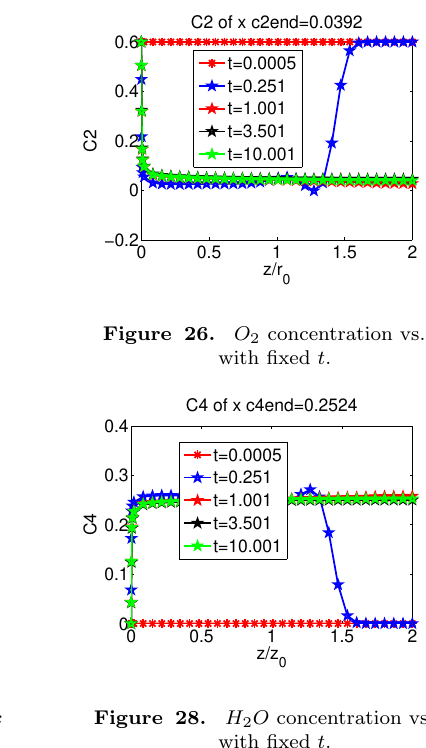
Figure 27. CO 2 concentration vs. x with fixed t .